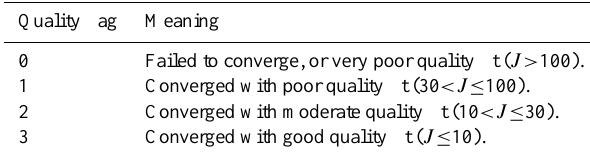
Table 2. Classification of quality flags in GRAPE level 2 products.